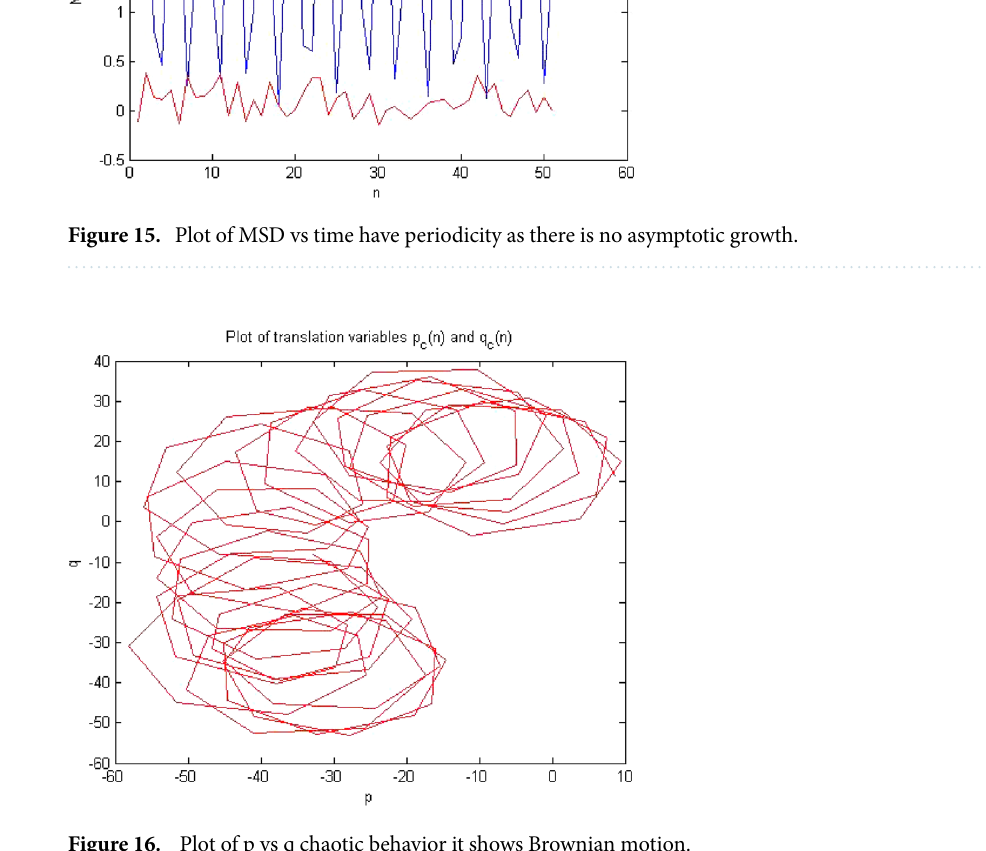
Figure 16. Plot of p vs q chaotic behavior it shows Brownian